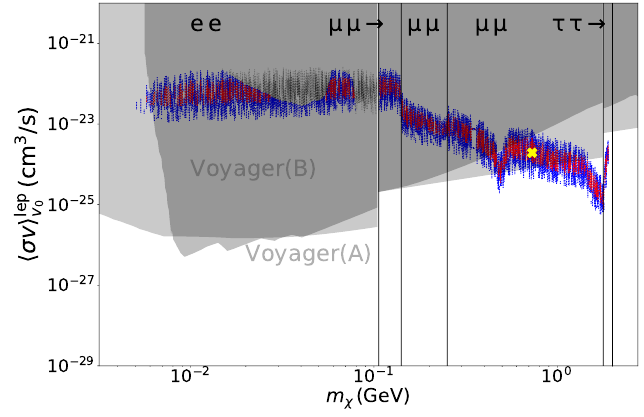
Figure 7 . The prediction of the scalar dark matter model obtained by casting the favored parameter sets discussed in section 3.5 onto the plane of the dark matter mass and the annihilation cross-section into SM lepton pairs. The colors used for the prediction are the same as those used in figure 6. The constraint obtained by the Voyager I observation at 90 % C.L. is shown by gray-shaded regions, where the “Propagation A” and “Propagation B” models [87, 94, 95], which describe the electrons/positrons propagation in our galaxy, are adopted for those in light- and dark-gray shaded